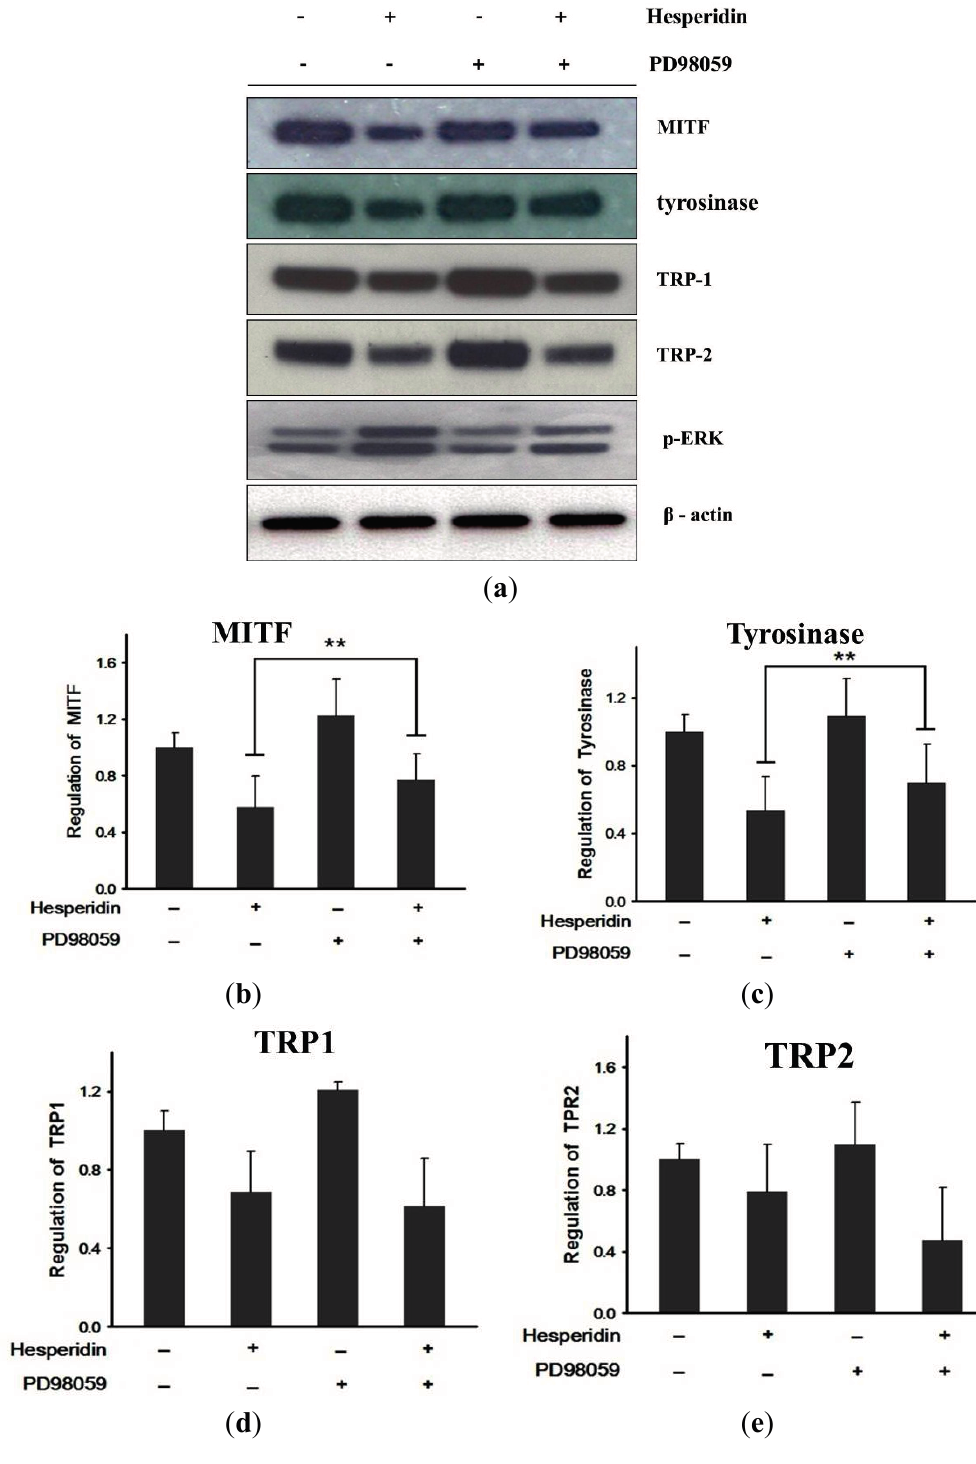
Figure 4. Effect of co-treatment with hesperidin and Erk1/2 inhibitor on melanogenesis-related protein in B16F10 cells. ( a ) Melanogenesis-related protein expressions were analyzed by Western blot; ( b ) MITF; ( c ) Tyrosinase; ( d ) TRP1; ( e ) TRP2 percentage values relative to that in α -MSH-stimulated cells. Data were expressed as mean ± SD of three independent experiments carried out in triplicates. ** p < 0.01 as compared to the one treated with hesperidin (30 μ M)